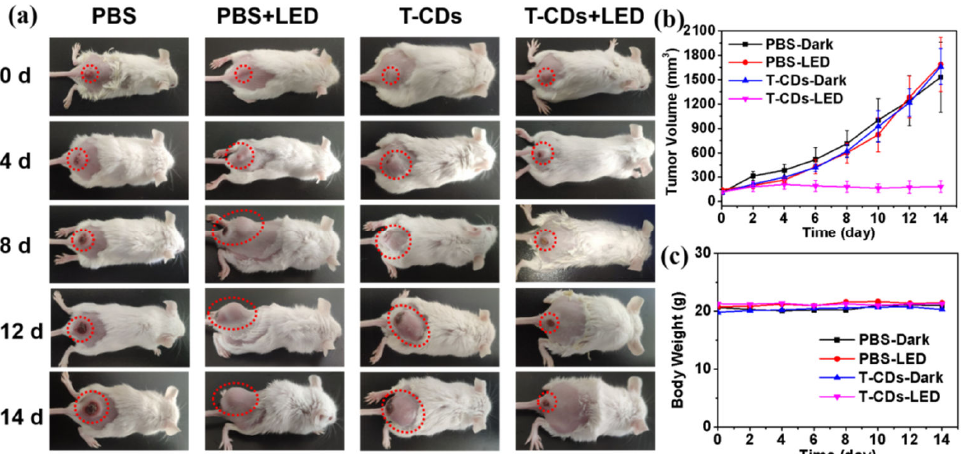
Figure 6. ( a ) Photographs of 4T1 − tumor − bearing mice on different days post various treatments. ( b ) Tumor volume changes in the indicated groups during treatment. ( c ) Body weight changes in the indicated groups during treatment.